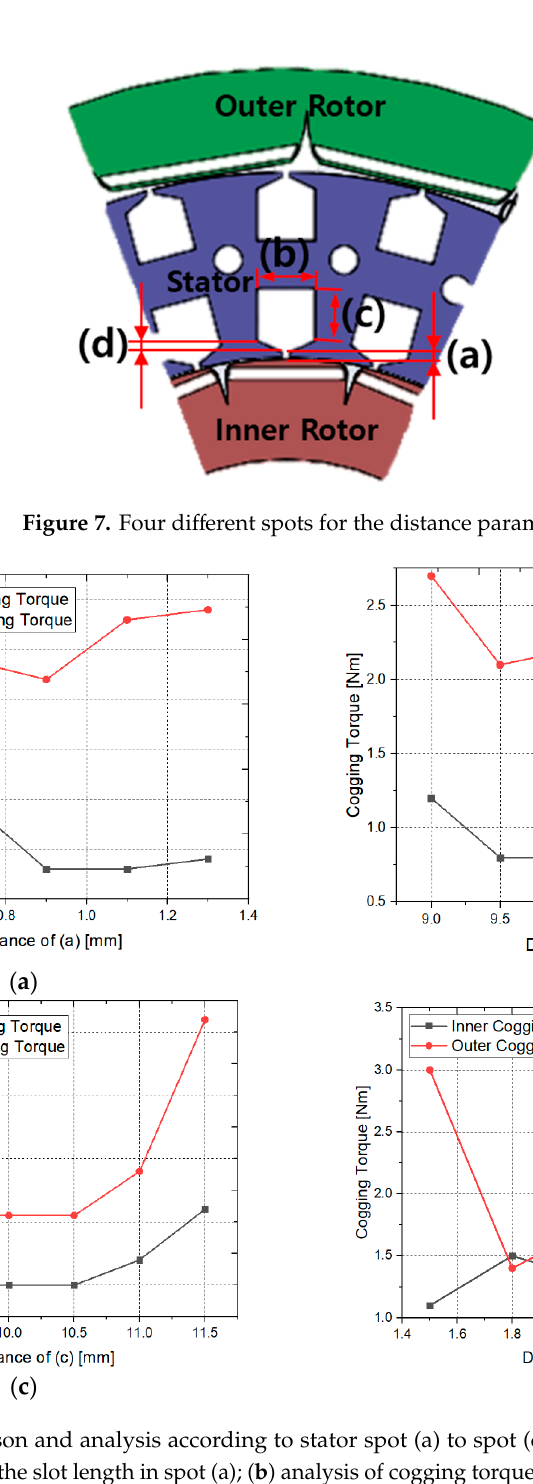
Figure 8. Comparison and analysis according to stator spot ( a ) to spot ( d ). ( a ) Analysis of cogging torque according to the slot length in spot ( a ); ( b ) analysis of cogging torque according to the slot length in spot ( b ); ( c ) analysis of cogging torque according to the slot length in spot ( c ); ( d ) analysis of cogging torque according to the slot length in spot ( d ).